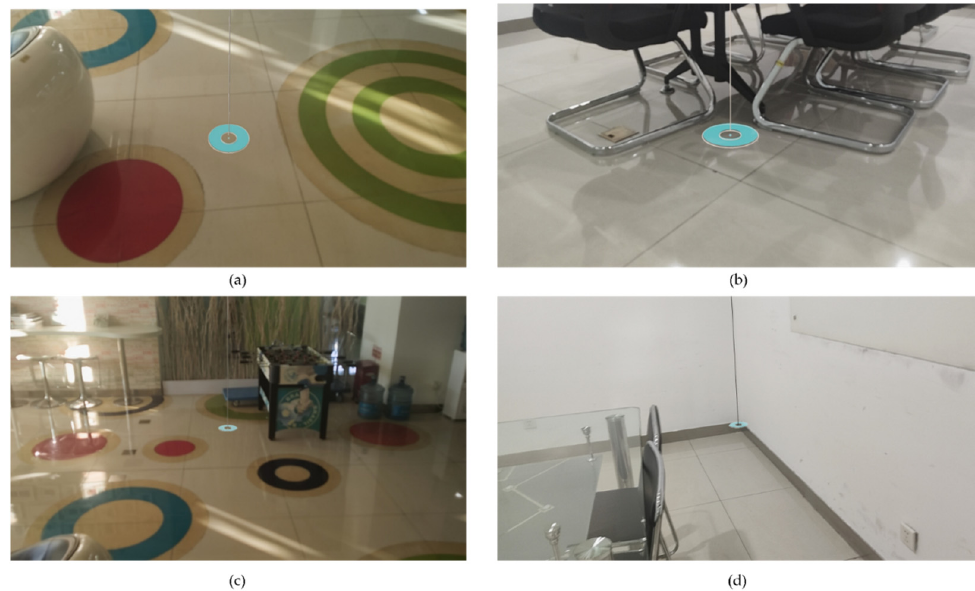
Figure 8. The combination of marker bar and ground circle to deal with snapping results at varying distances that impose visual limitations: ( a ) close-up snapping of the office area; ( b ) close-up snapping result of the conference room; ( c ) long-distance snapping of the office area; ( d ) long-range snapping of the conference room.